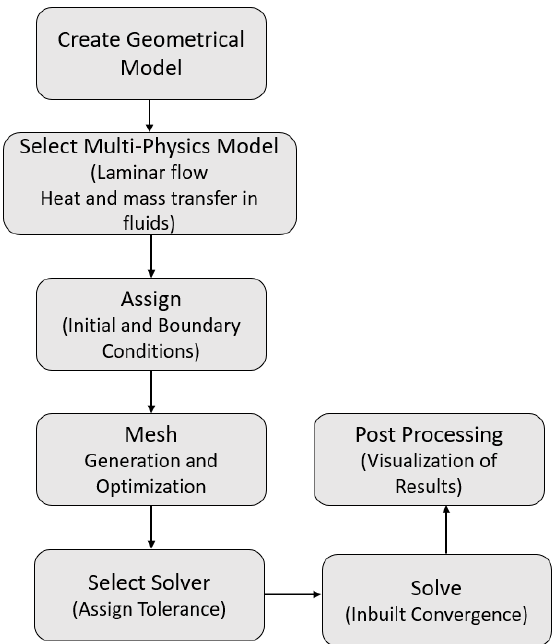
Figure 2. Illustration of the steps involved in COMSOL Multiphysics software.